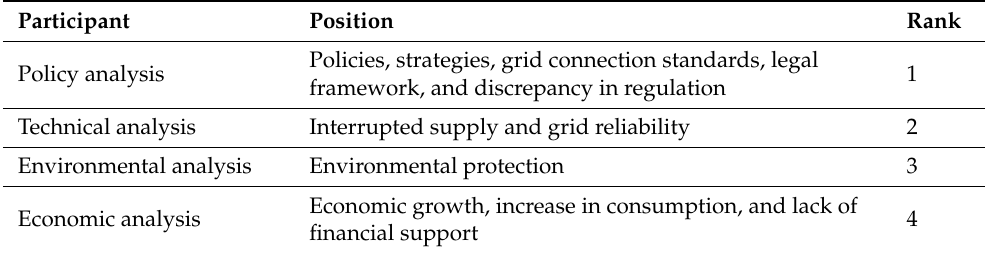
Table 9. Ranking of The Combined Renewable Energy Deployment Factors.